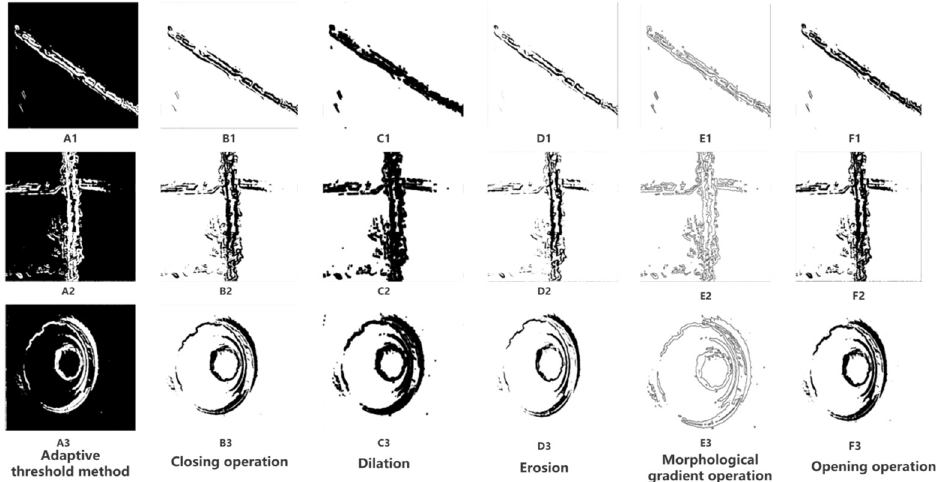
Figure 10. Comparison chart of different morphological operations.